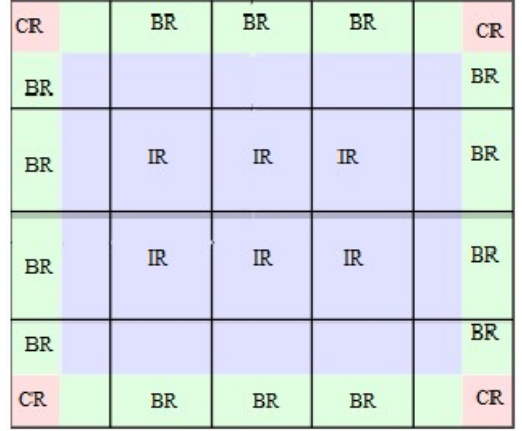
Figure 1. Structure of regions of an image.